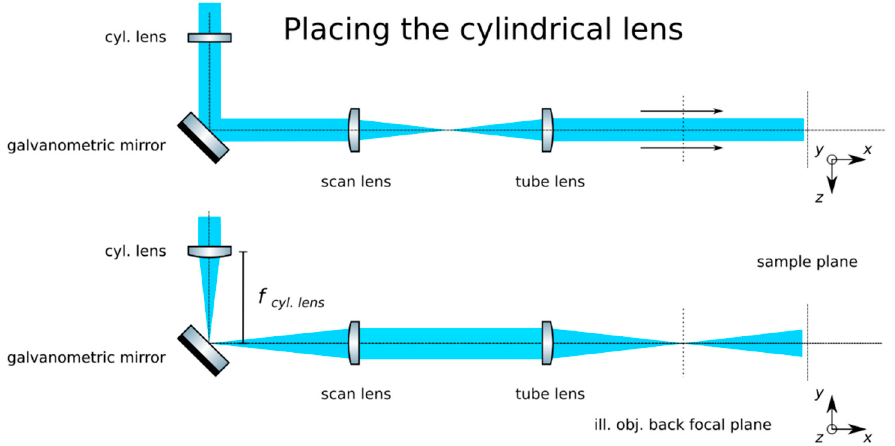
Figure 6. Place the cylindrical lens before the galvanometric mirror. Ensure that its focal plane lies on the mirror’s surface.